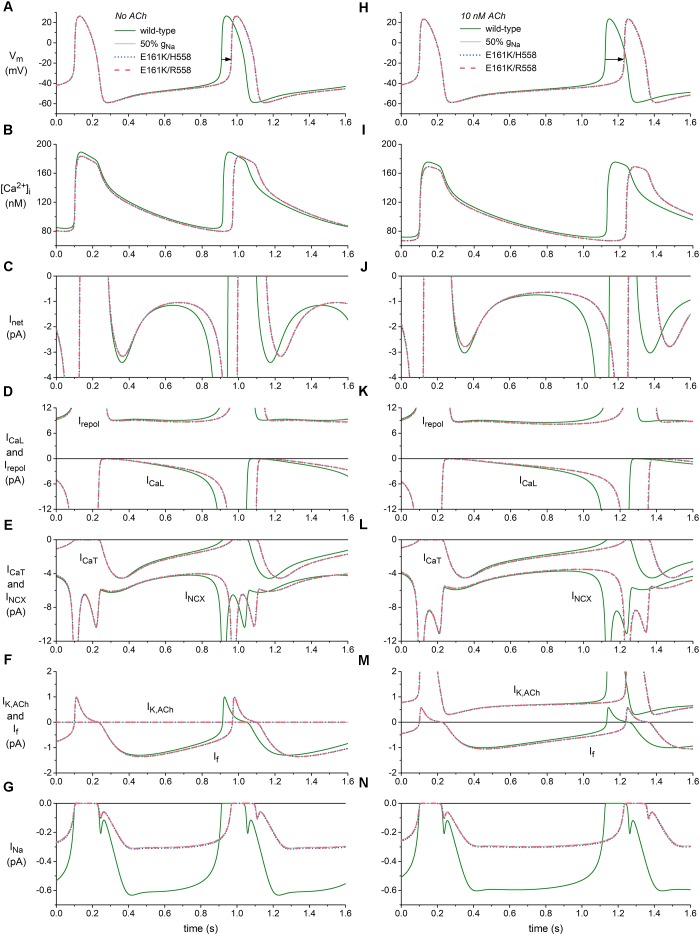
Effects of the E161K mutation in SCN5A, either in H558 or R558 background, on the spontaneous activity of the Fabbri-Severi model of a human SA nodal pacemaker cell. (A) Membrane potential (Vm), and associated (B) intracellular calcium concentration ([Ca2+]i), (C) net membrane current (Inet), (D) L-type calcium current (ICaL) and total repolarizing current (Irepol), (E) T-type calcium current (ICaT) and sodium-calcium exchange current (INCX), (F) ACh-activated potassium current (IK,ACh) and hyperpolarization-activated “funny current” (If), and (G) fast sodium current (INa) in the absence of ACh. (H) Vm, (I) [Ca2+]i, (J) Inet, (K) ICaL and Irepol, (L) ICaT and INCX, (M) IK,ACh, and If, and (N) INa during simulated administration of 10 nM ACh. Solid gray lines show the effect of a 50% reduction in fully-activated conductance of INa (gNa). Horizontal arrows indicate increase in cycle length. Irepol consists of IK,ACh, the rapid delayed rectifier potassium current IKr, the slow delayed rectifier potassium current IKs, the ultrarapid delayed rectifier potassium current IKur, the transient outward potassium current Ito, and the sodium-potassium pump current INaK.